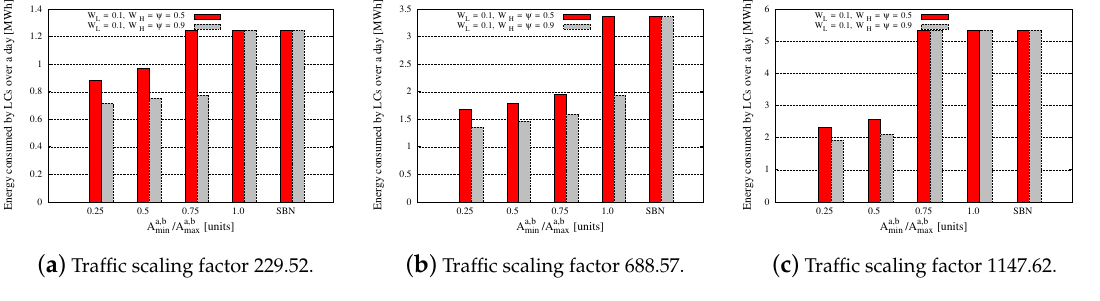
over a day vs. the ratio A a , b / A a , b max . min total